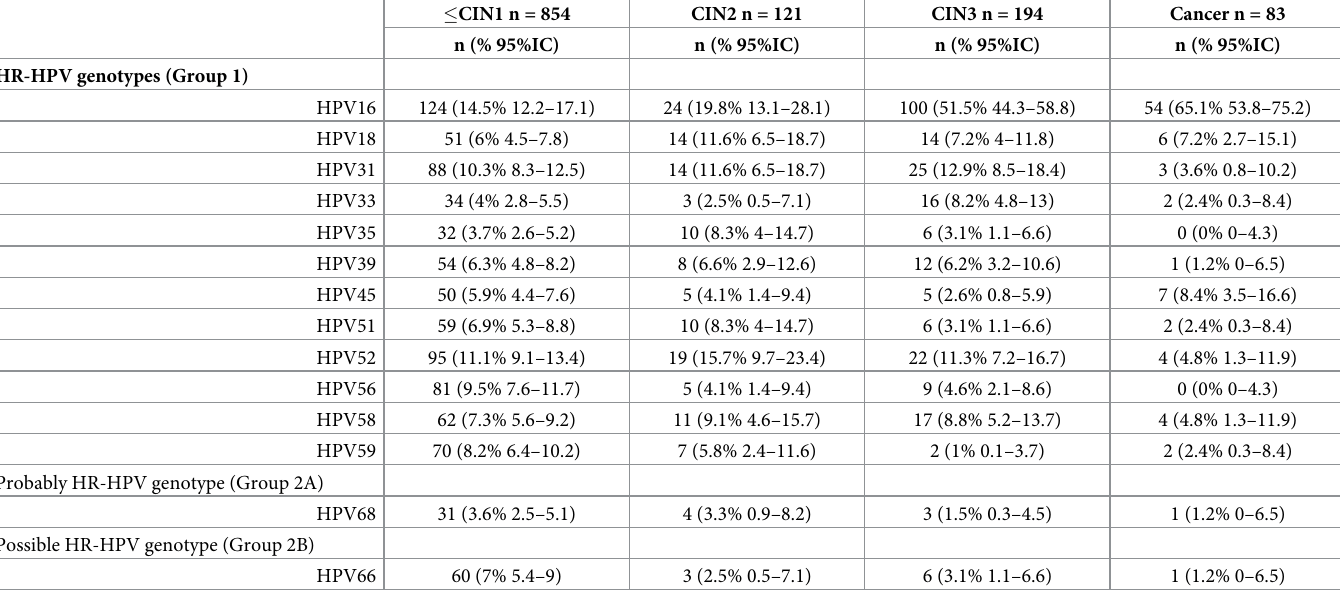
Table 3. Prevalence of high-risk (HR) HPV genotype infections within histological diagnoses in HPV screened positive women.